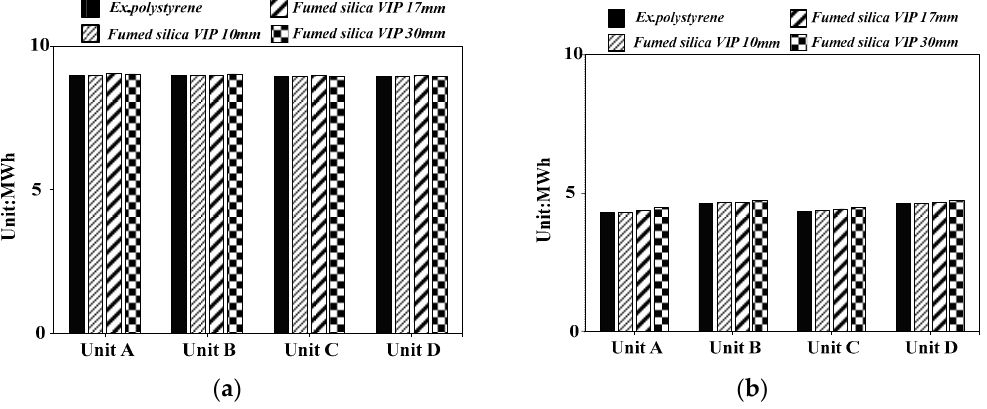
Figure 6. The effect of fumed silica VIPs on building energy consumptions. ( a ) Heating loads; ( b ) Cooling loads.